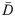
Genetic diversity within hosts.Bacteroides vulgatus is shown as an example in panels A–E; examples for 24 other species are shown in S1 Fig, S2 Fig, and S3 Fig. (A–D) The distribution of major allele frequencies at synonymous sites in the core genome for four different samples, with the median read depth D¯ listed above each panel. Major allele frequencies are estimated by max{f,1−f}, where f is the frequency of the base on the reference genome (S1A Text, part iii). To emphasize the distributional patterns, the vertical axis is scaled by an arbitrary normalization constant in each panel, and it is truncated for visibility. The white region denotes the intermediate frequency range used for the polymorphism calculations below. (E) The average fraction of synonymous sites in the core genome with major allele frequencies ≤80% (white region in A–D), for all samples with D¯≥20. Vertical lines denote 95% posterior confidence intervals based on the observed number of counts (S1B Text). The letters indicate the corresponding values for the samples in panels (A–D) for comparison. (F) The distribution of quasi-phaseable (QP) samples among the 35 most prevalent species, arranged by descending prevalence; the distribution across hosts is shown in S7 Fig. For comparison, panels (C) and (D) are classified as QP, while panels (A) and (B) are not.